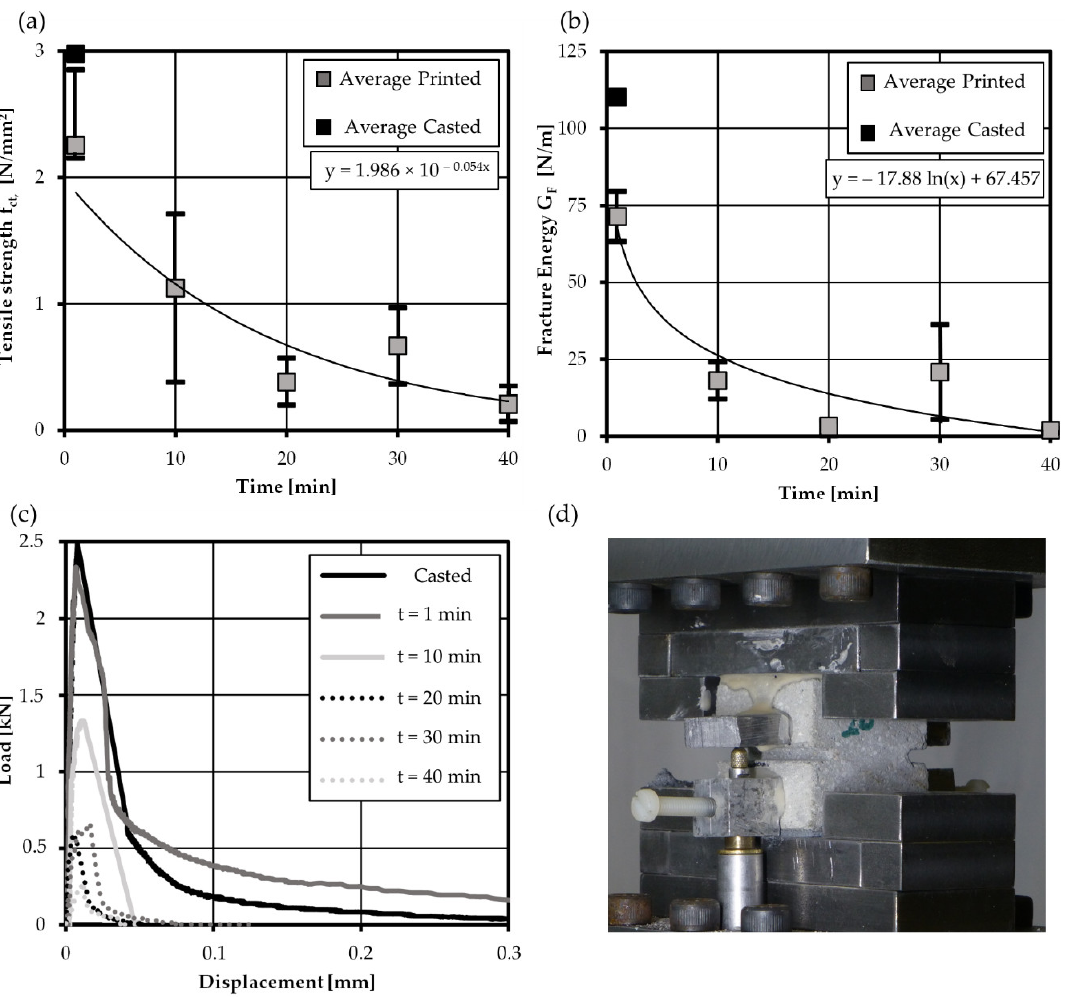
Figure 11. Results of uniaxial tensile tests—development of ( a ) average flexural strength and ( b ) average fracture energy with increasing interval time, ( c ) exemplary load deflection curves and ( d ) closeup-view on test setup.